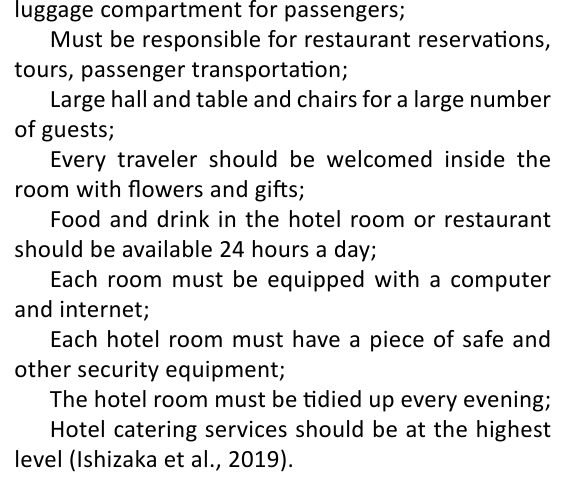
Fig 2: Hugman crisis management model ( Clark, 2010)